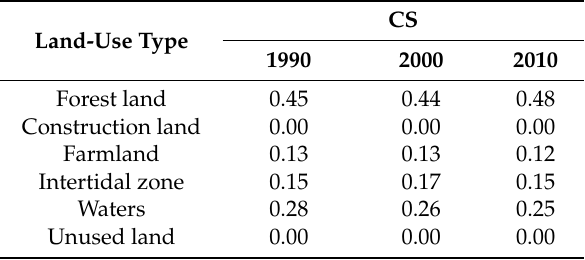
Table 7. The sensitivity index of the ESV coefficient.